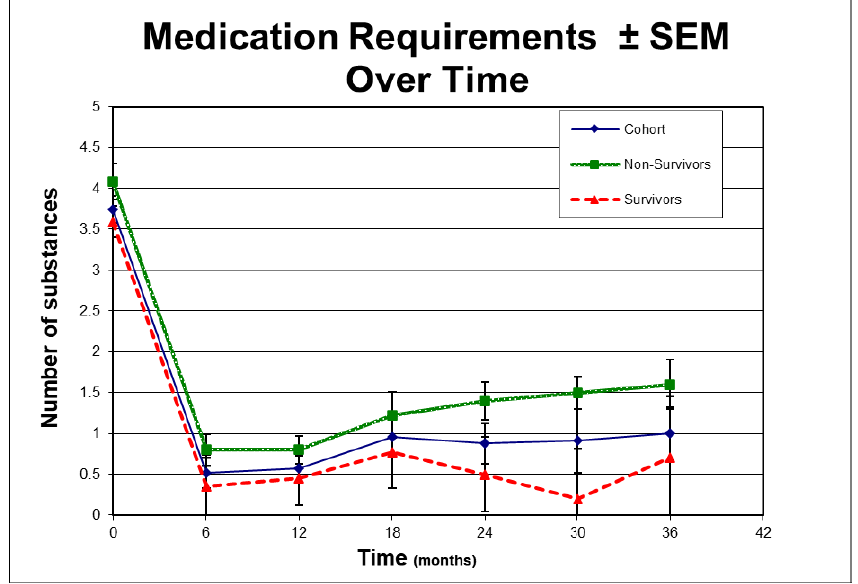
Figure 6. Average post-op medication requirements for all patients (cohort), for those who failed by visual function criteria (non-survivors) and for those who successfully maintained visual function (survivors) as outlined in methods. Error bars represent standard error of measurement (SEM) at respective time-points. Medication requirements differed between survivors and non-survivors significantly at 24 months ( p = 0.03, one tail student ’ s t- test) and 30 months ( p = 0.05, one tail student ’ s t- test). Table 3. Univariate risk factor analysis of various pre-, intra- and post-op parameters possibly affecting survival of visual function (not bleb survival) in this cohort of patients with advanced glaucoma undergoing standard guarded trabeculectomy or phaco-trabeculectomy.